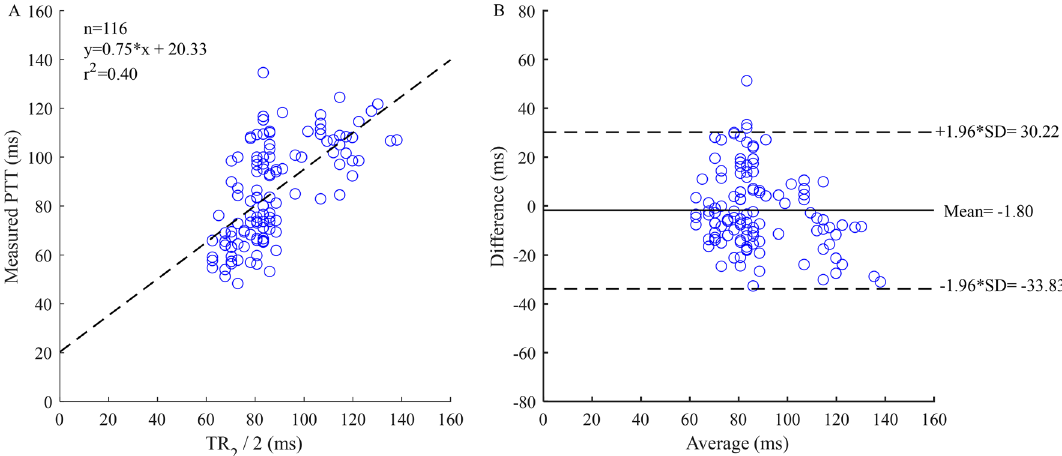
Figure 8. Correlation graphs and Bland–Altman plots comparing measured and calculated PTTs. ( A ) Scatter plot of the calculated PTT (TR 2 /2) vs measured carotid to femoral transit time (cfPTT) with regression line (dashed line) in all data. ( B ) Bland Altman plot of TR 2 /2 vs cfPTT in all data. Solid line is the mean difference, and the dashed lines are ± 1.96 SD of the difference. Difference: Measured cfPTT − calculated PTT; Average: (Measured cfPTT + calculated PTT)/2.